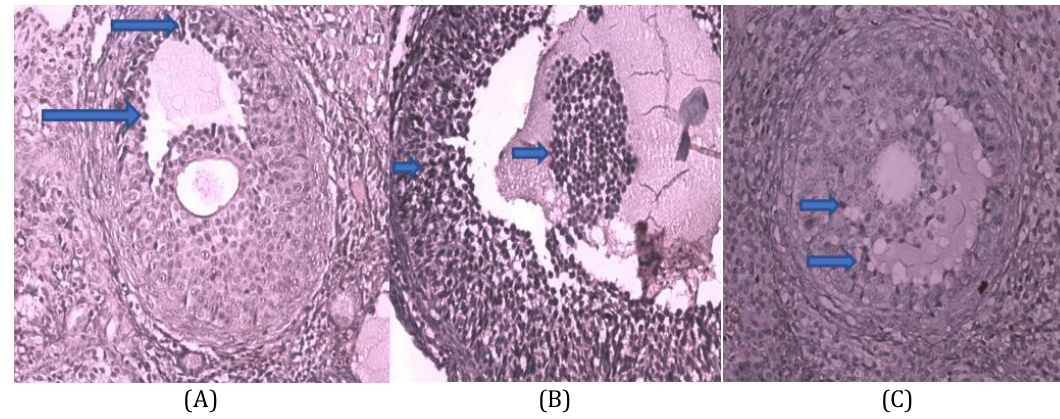
Figure 3. Expression of rat ovarian granulosa cell apoptosis (A) C- group; (B) C+ group; (C) E group. Observations were done using light microscope in a magnification of 400